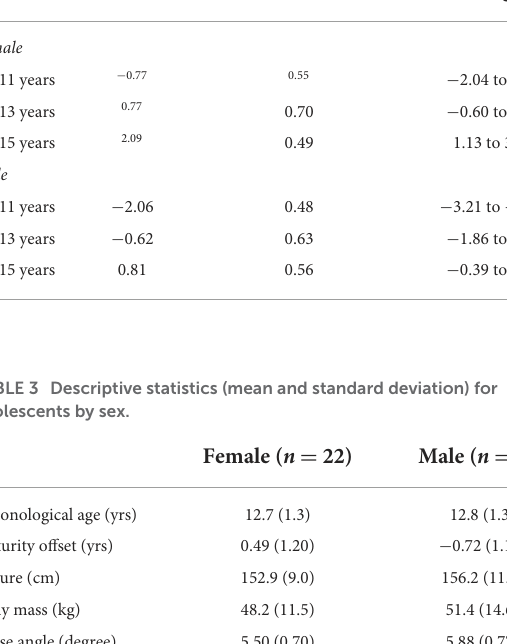
TABLE 2 Mean, standard deviation and range of maturity offset in the sample of adolescents by sex and age group. Mean Standard deviation